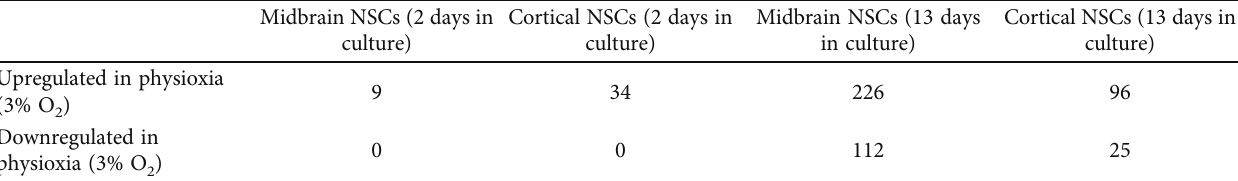
Figure 1: Comparison of gene expression levels measured with microarray gene chip assay and qRT-PCR showing good correlations between both measurements in mNSC. Log2-transformed fold changes in mRNA levels (3% O ( n = 3 ) were plotted for both array and qRT-PCR. Table 1: Number of genes up- or downregulated more than twofolds in NSCs in physioxia.